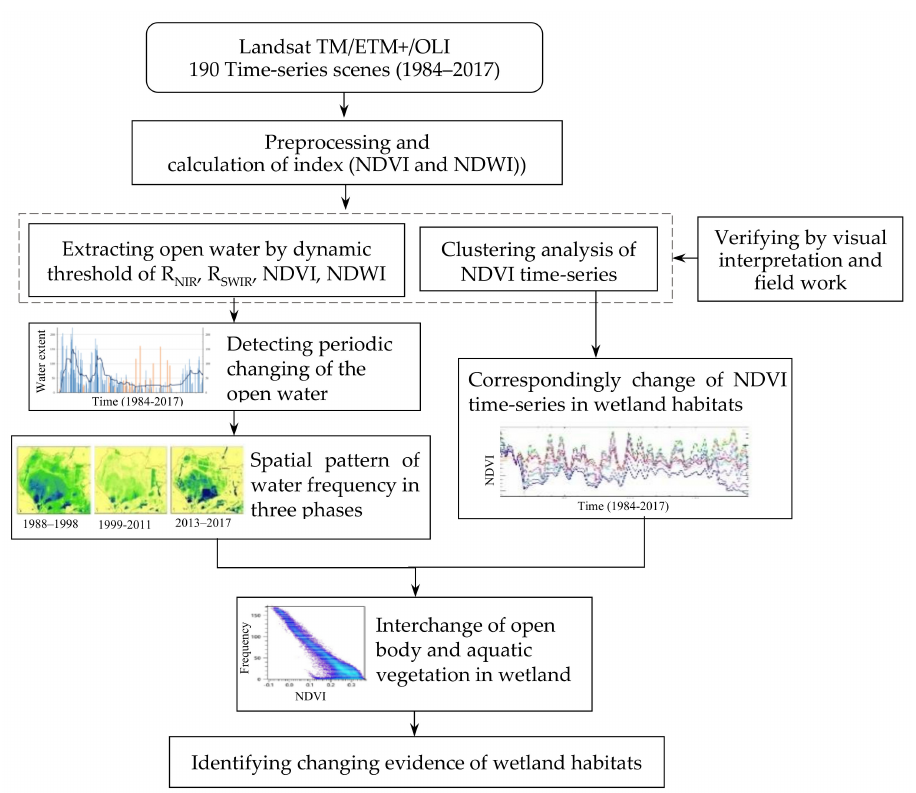
Figure 3. Flow chat of tracking changing evidences of water in wetland using the satellite observing